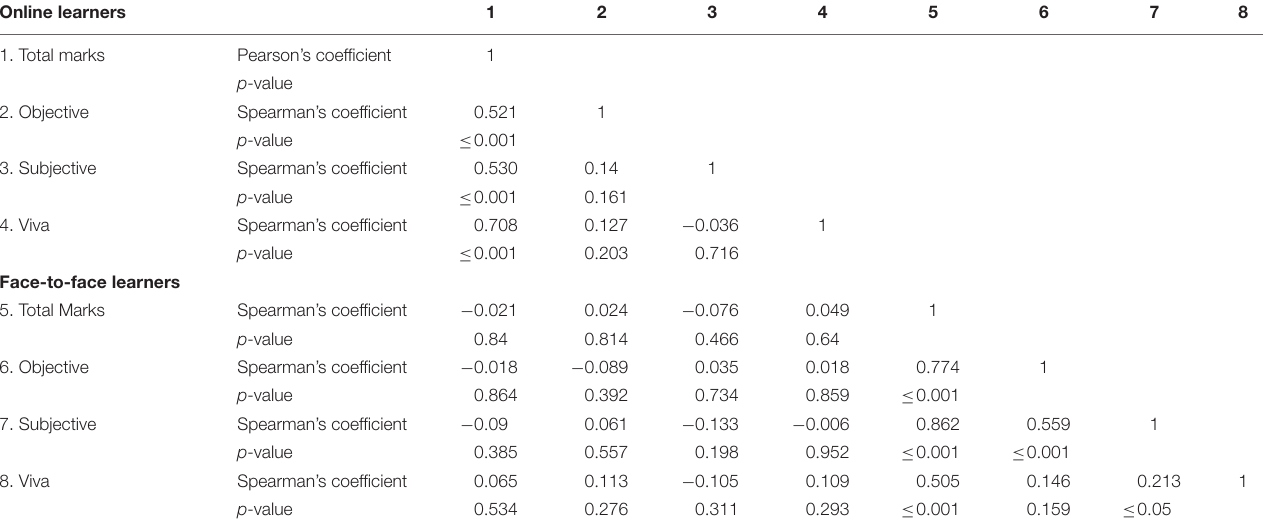
TABLE 10 | Correlation of examination results of online and face-to-face learners. Online